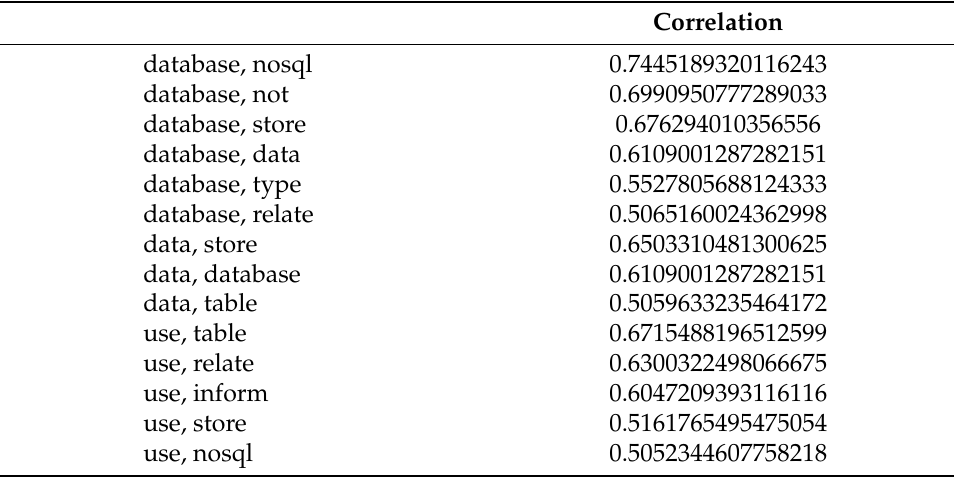
Table 3. Samples of the word association table extracted from all